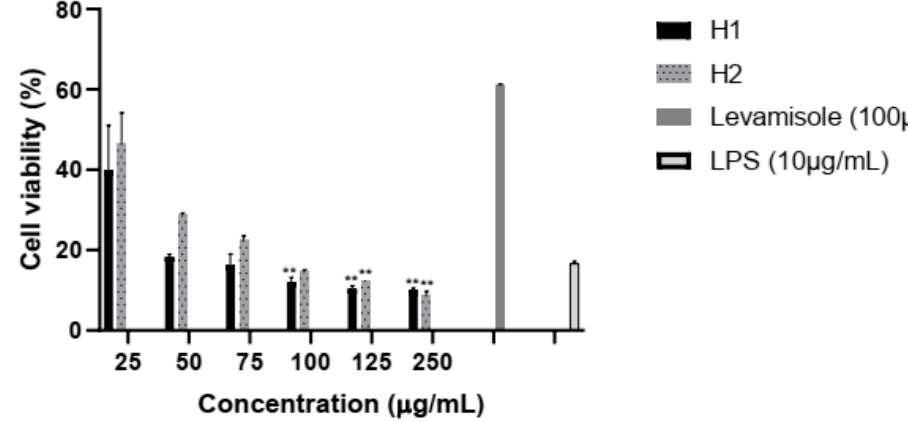
Figure 4. Viability of NR8383 cells after 18 h exposure to hellebore extracts, and LPS (10 µg/mL). Levamisole (100 µg/mL) was used as positive control and LPS alone (10 µg/mL) as negative control. Values represent mean ± SD (n = 3, ** p < 0.01).